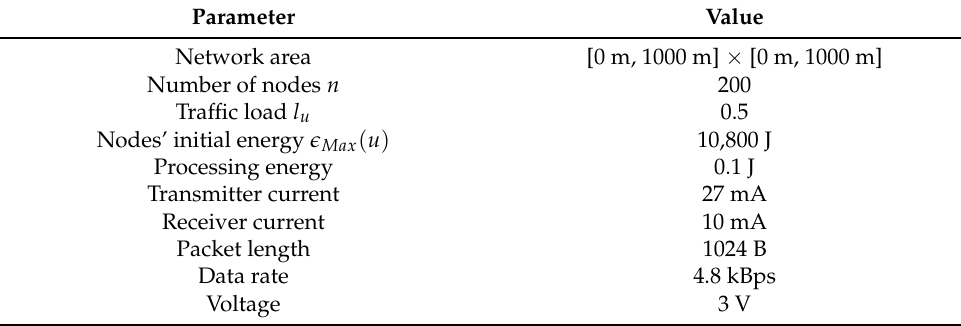
Table 1. Simulation Network